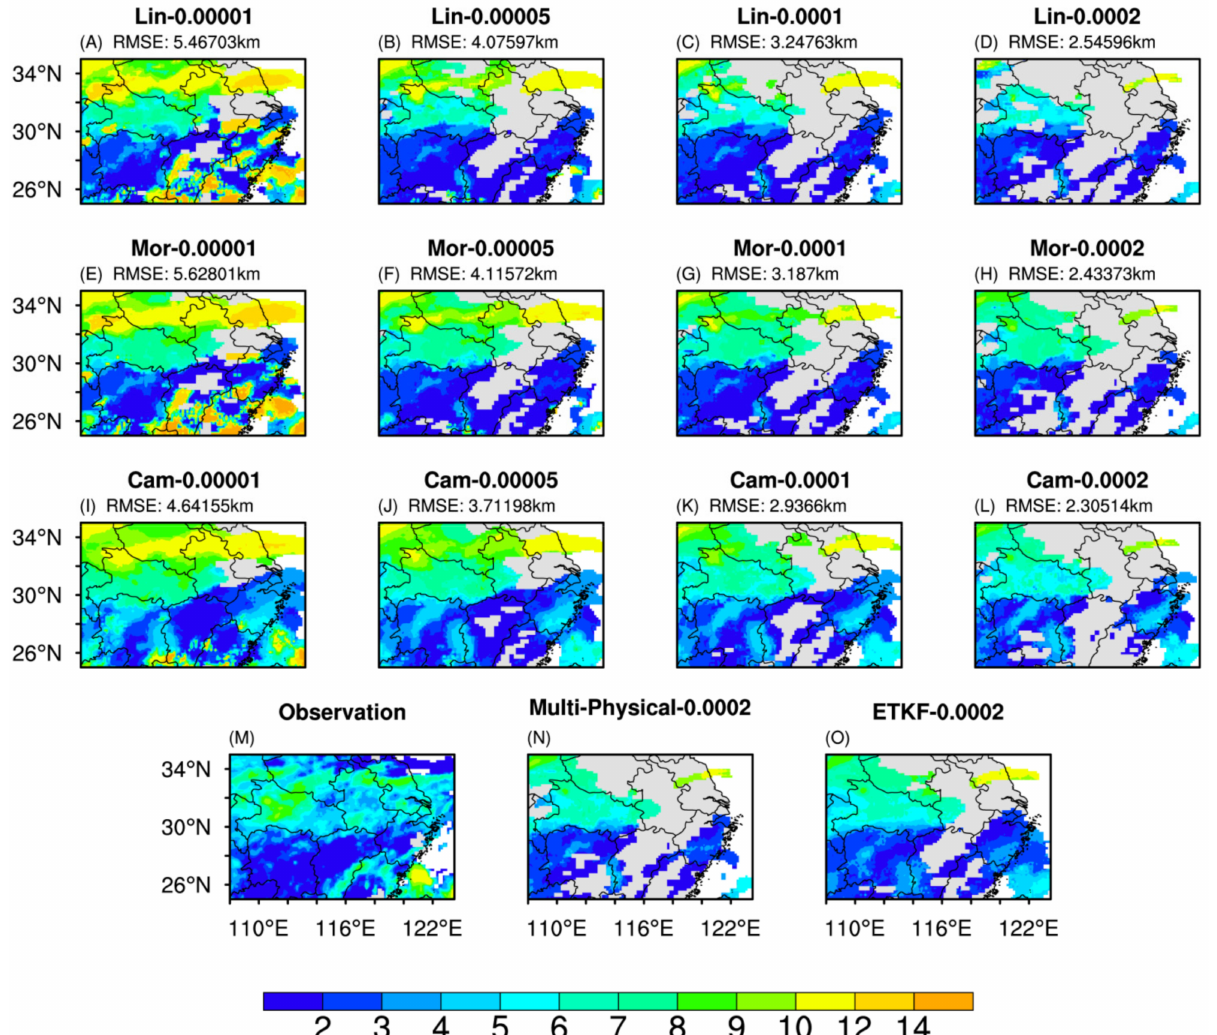
Figure 2. Geographical distribution comparison of the cloud-top height (km) between the simulations for four thresholds at 0600 UTC on 12 August 2014 by the ( A – D ) Lin, ( E – H ) Morrison 2-mom, ( I – L ) CAM5.1 microphysical parameterization schemes and ( N ) Multi-Physical, ( O ) ETKF, ( M ) the satellite observation data and their root mean square errors